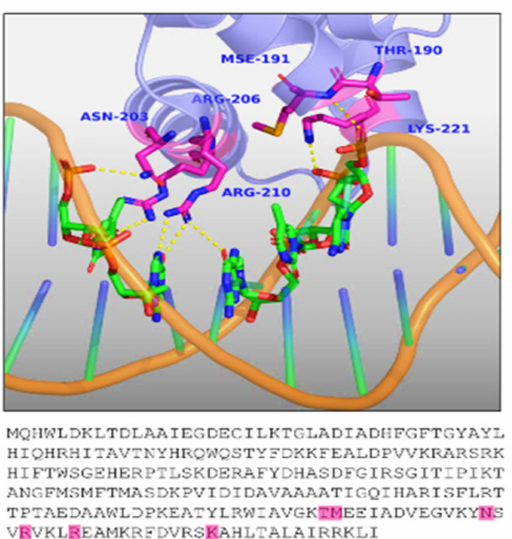
Figure 7. DNA-binding site analysis of TraR. The representation of cartoon sticks shows the contact residues of the DNA-binding site and the FASTA sequence highlights the residues involved in ligand interactions (magenta: h-bond-forming residues). The receptor is highlighted in slate with cartoon